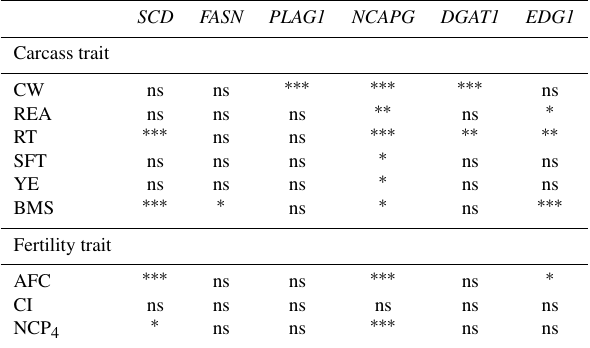
Table 4. Association between markers and traits in the Japanese Black cattle population ( n =